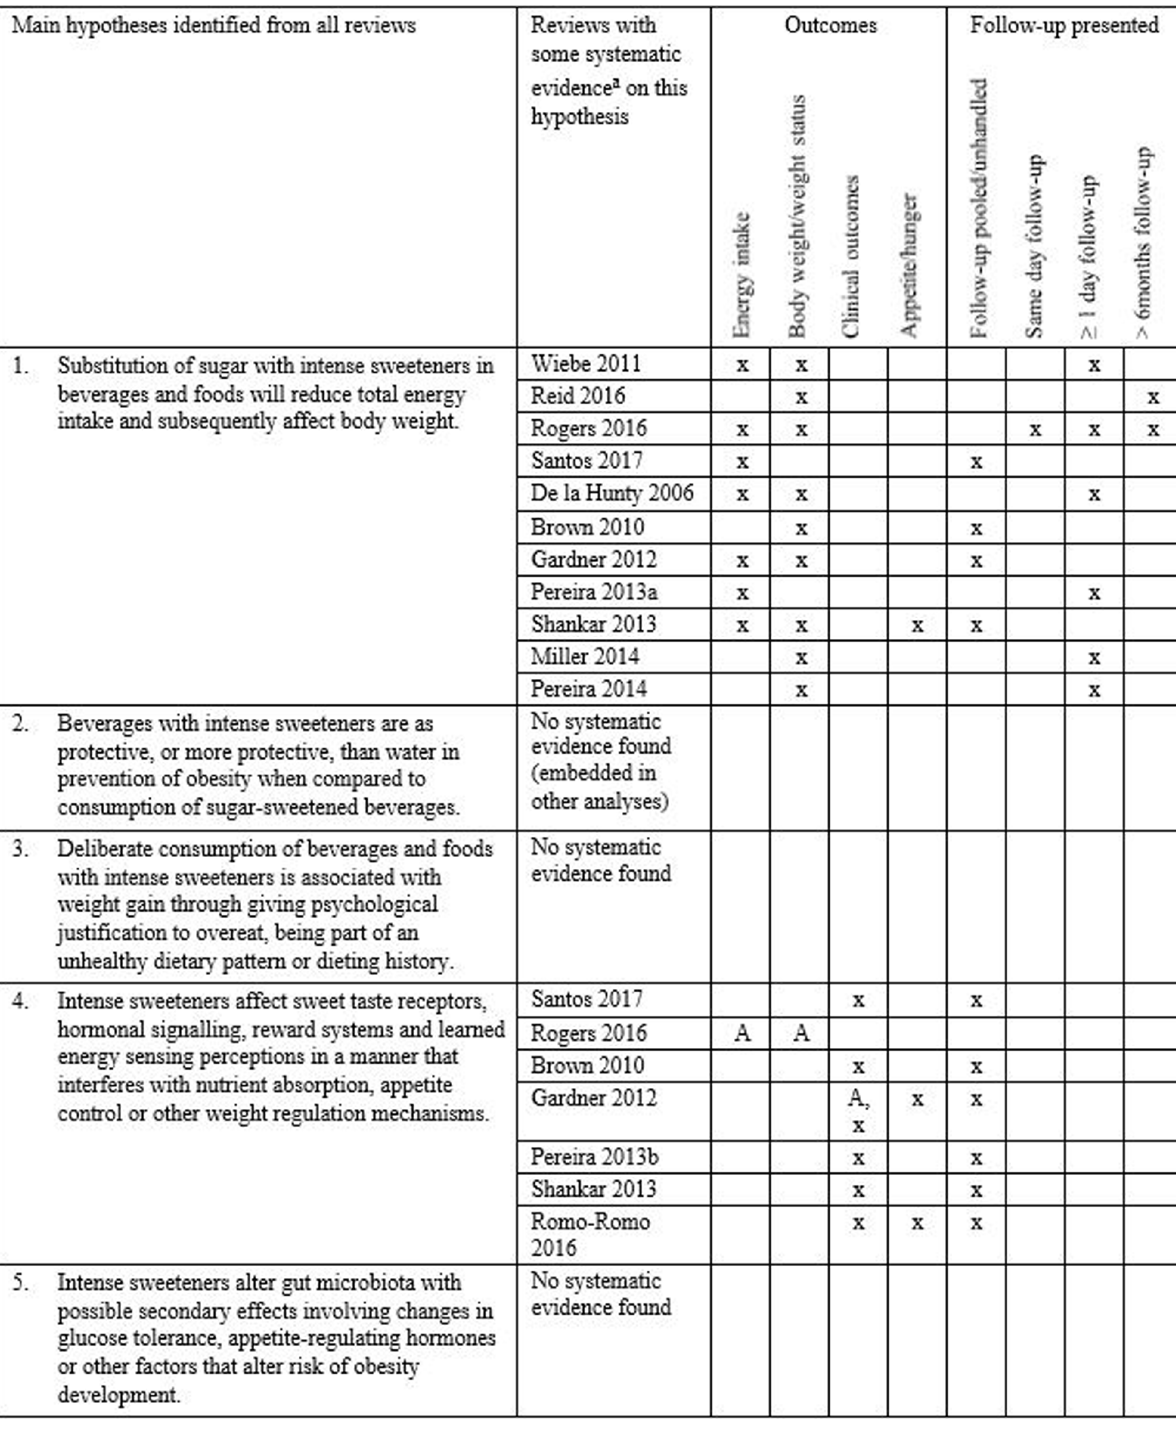
Fig 3. Main hypotheses identified from all included reviews mapped against the evidence found in systematic reviews and reviews with systematic approach to study selection. a Data extracted from systematic reviews and reviews with description of systematic approach (from Table